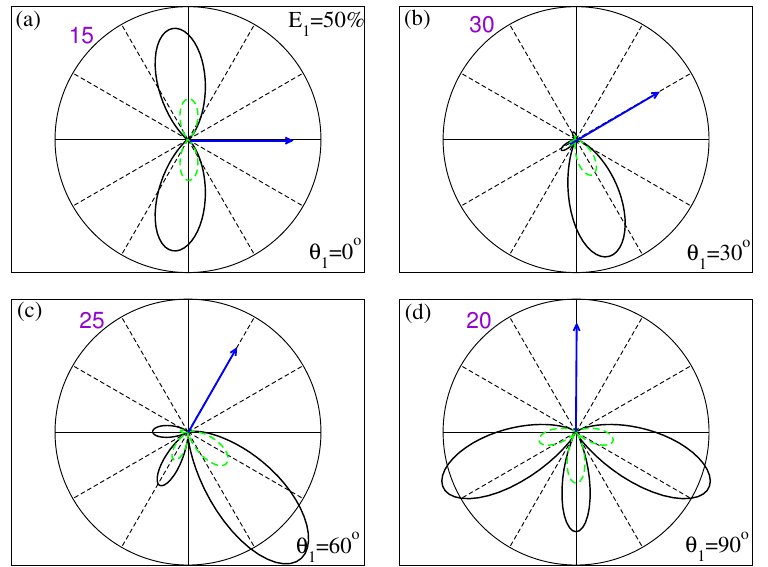
Figure 3. Triple-differential cross-section (TDCS) results from DPI of 3 P carbon at 10 eV excess energy ( ω = 45.2 eV) and equal energy sharing ( E 1 = E 2 ). Each panel ( a – d ) shows the resulting angular distribution of the second electron when the first electron direction (blue arrow) is fixed at the angle shown relative to the polarization direction (horizontal). Present results for carbon (solid black line) are shown and compared with neon results (dashed green line) for the same 3 P initial-state coupling of the outgoing electrons and at similar excess energies as a percentage of the double ionization potential ( ω = 83.7 eV for neon). The purple numbers in each panel indicate the magnitude of the cross-section (in b/(eV sr 2 ) and establishes the radius of each circle. 1 b = 10 − 24 cm 2